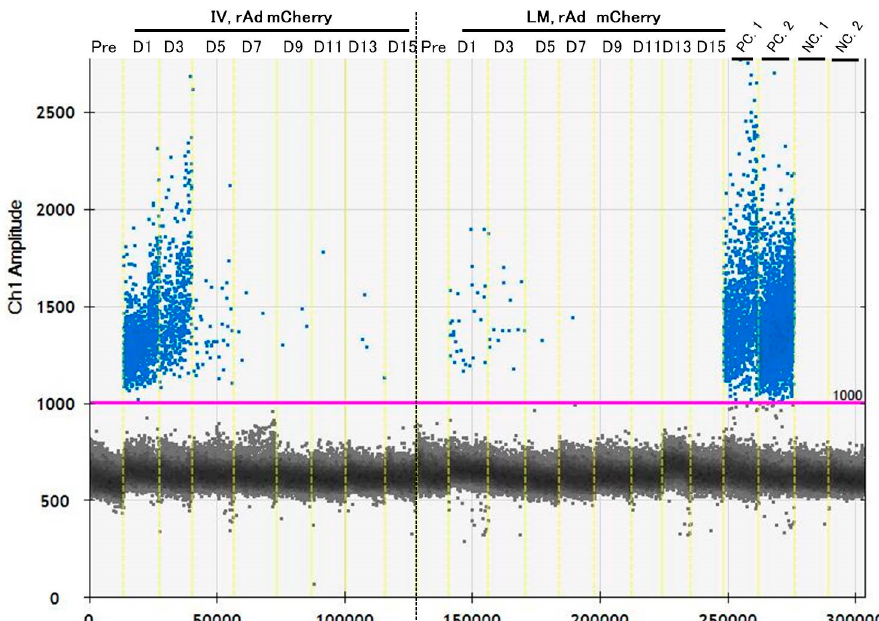
Figure 5. 1-D plot of data showing detected transgene fragments in ddPCR reactions until 15 day after injection of the rAdV vectors. These plots show a mean positive for the transgenes in whole blood DNA pooled from six mice each day. Transgene fragments could be detected repeatedly. In particular, the detection of fragments was higher on days 1 (D1) and 2 (D2). The blue plots denote a positive presence and black plots denote a negative presence of transgene fragments. IV means intravenous injection, and LM means local muscular injection of the rAdV in the tibialis anterior (TA) muscle. PC. 1: positive control of rAdV DNA containing the mCherry gene (10 pg / µL). PC. 2: positive control of liver DNA containing the mCherry gene with induced rAdV (10 ng / µL). NC. 1: negative control of mouse DNA (50 ng / µL). NC. 2: distilled water (DW) as a negative control.